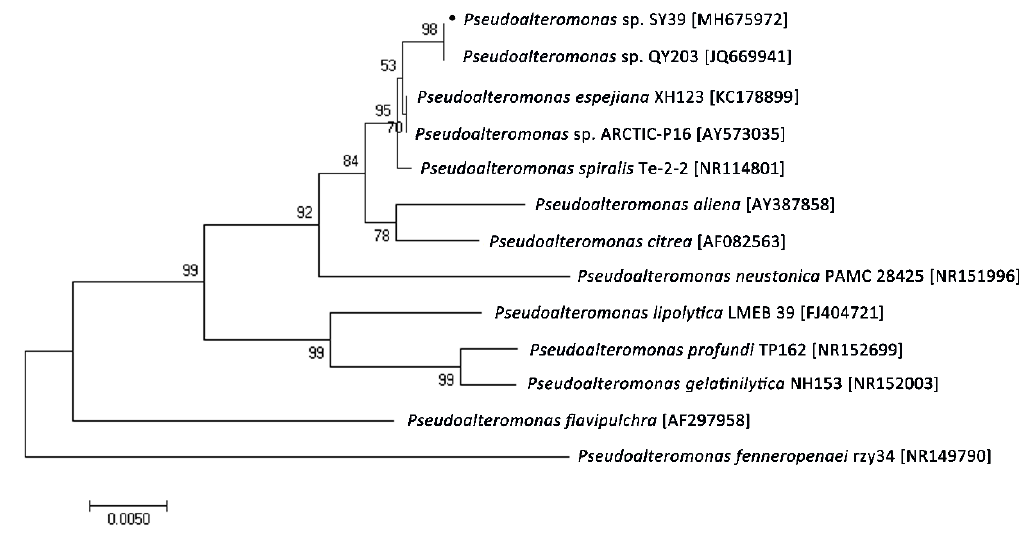
Figure 1. Phylogenetic relationship of the strain SY39. The evolutionary history was inferred using the maximal parsimony analysis of the 16S rDNA sequences. The 16S rDNA sequence was obtained by using the ClustalX and BLASTn programs, respectively. Phylogenetic analysis was carried out using MEGA 7.0 software.